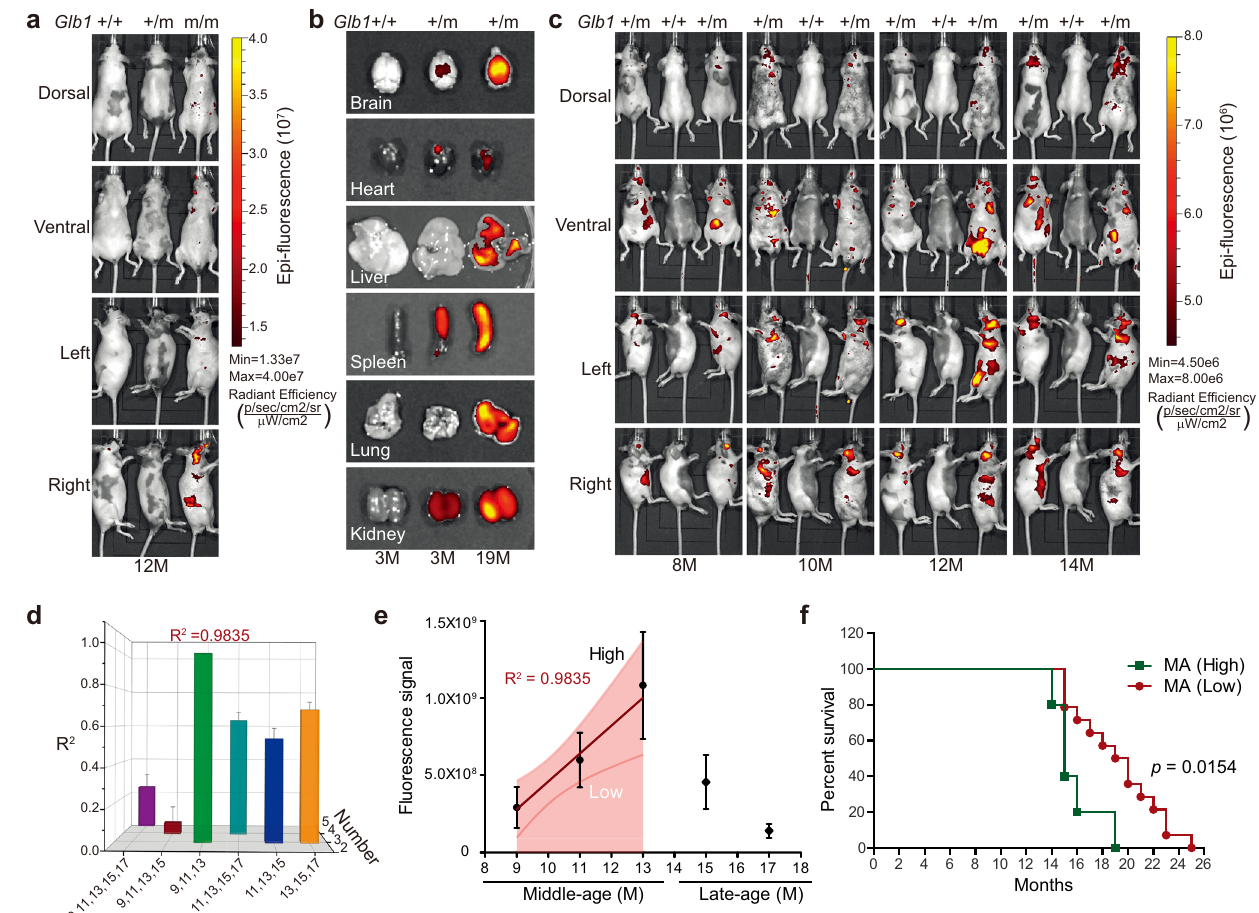
Fig.4|Live-imagedGACsignalcorrelateswithlifespan.a Representativeimages showingliveGACsignaldetectedbyanIVISLuminaIIsystemin Glb1 m/m , Glb1 +/m ,and Glb1 +/+ miceat12monthsofage. b RepresentativeimagesshowingliveGACsignalin indicatedorgansisolated from3-month-old Glb1 +/+ and Glb1 +/m miceand19-month- old Glb1 +/m mice. c RepresentativeliveGACsignalimagesofacohortof Glb1 +/m mice ( n =60) at indicated ages. A Glb1 +/+ mouse was included as a background control. d A cohort of Glb1 +/m mice ( n =60) at 9, 11, 13, 15, and 17 months of age were live- imaged, and linear regression between GAC signal and chronological age was analyzed.There was a close correlation between GACsignaland chronologicalage